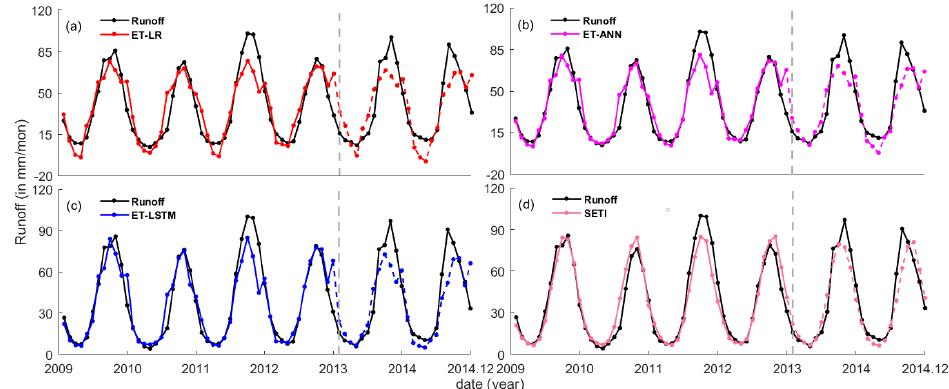
Figure 7. Reconstructed (solid line) and predicted (dash line) runoff at the TC–CD station pair based on remotely sensed evapotranspiration ( ET ) averaged over the whole upstream area from the Tibetan Plateau to the southern boundary of Cambodia via ( a ) linear regression (LR), ( b ) ANN, ( c ) LSTM, and ( d ) data standardization.